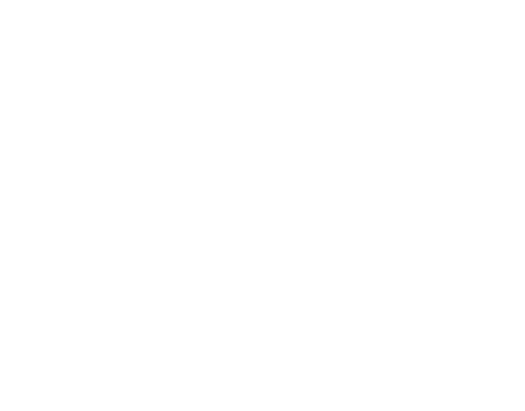
Figure 2. Internal brace ligament augmentation of the right knee, frontal view. This image can be found in the “ACL Primary Repair with Internal Brace Surgical technique” brochure,